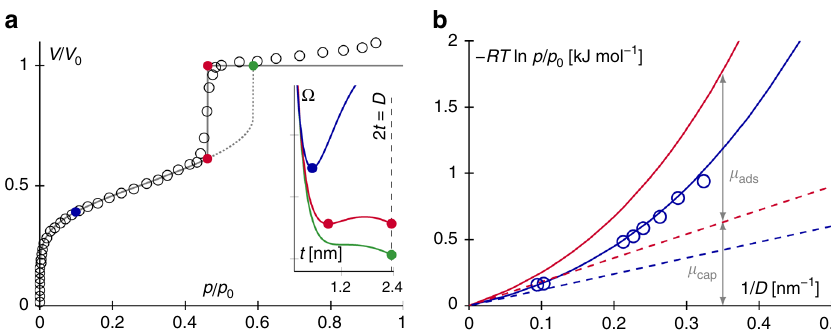
Fig. 5 Thermodynamic modeling of adsorption in nanoporous materials. a Experimental N 2 adsorption isotherm at 77 K for a MCM-41 porous silica with cylindrical pores of a diameter D = 4.7 nm (circles). The lines are the predictions from Derjaguin ’ s model as derived in the present work for a cylindrical geometry. The solid line represents the at-equilibrium data where the transition pressure is de fi ned as the pressure for which the grand potential Ω for the fi lled pore equal that for the partially fi lled pore (an adsorbed fi lm coexisting with the gas phase in the pore center). The dashed line corresponds to data with the condensation pressure de fi ned as the pressure for which the partially fi lled pore becomes unstable. The insert shows the grand potential Ω ( t ) as a function of t for the different regions of the adsorption isotherm. In the low pressure range, the stable solution (blue sphere) corresponds to the blue free energy pro fi le: the solution corresponds to a minimum te which corresponds to an adsorbed fi lm. At the coexistence pressure, the two minima indicated by the red spheres correspond to the equality of the grand potentials, Ω ( t e ) = Ω ( t = D /2). At the metastable condensation pressure (green sphere), the minimum corresponding to the partially fi lled pore disappears and the only stable solution corresponds to t = D /2. b Chemical potential shift μ 0 − μ at which capillary fi lling in a pore of a diameter D occurs. The shift μ 0 − μ = − RT ln( p / p 0 ) is de fi ned as the difference between the chemical potential μ at condensation and the chemical potential at the bulk gas/liquid phase coexistence μ 0 (note the negative sign which is used for convenience here). The red and blue solid lines are the Derjaguin model as derived in the present work for spherical and cylindrical pores, respectively (the dashed lines are the predictions from the Kelvin equation for these two geometries). The open circles are experimental data for MCM-41 porous silica with cylindrical pores having different diameters D